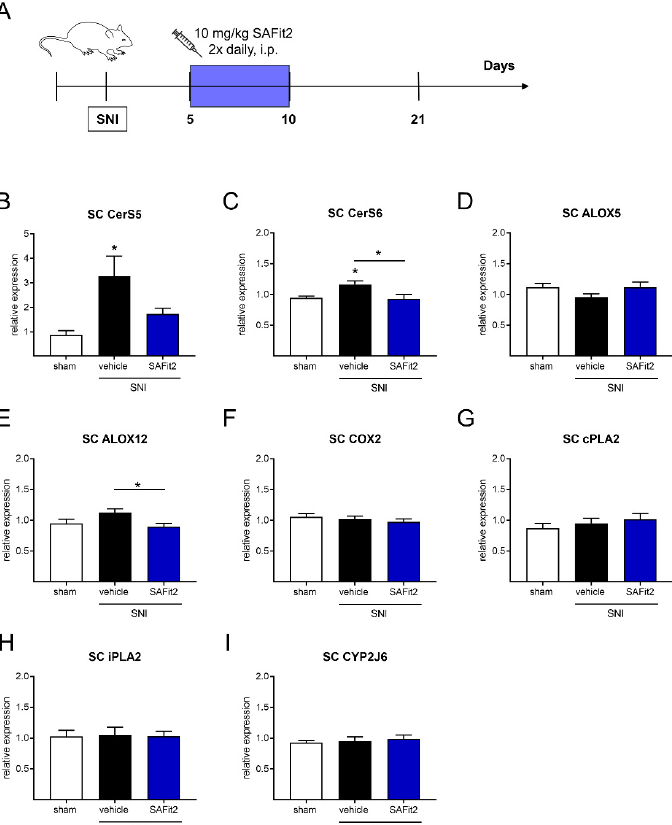
Figure 2. Gene expression of ceramide synthases, lipoxygenases, phospholipases, and epoxygenases in the spinal cord of nerve-injured mice after additional SAFit2 treatment. ( A ) Schematic illustration of the experimental procedure: SNI surgery was performed followed by treatment with either 10 mg/kg SAFit2 or the vehicle on six consecutive days (days five to ten) after SNI, as depicted in Figure 1. The gene expression of ceramide synthases ( B , C ), lipoxygenases ( D – F ), phospholipases ( G , H ), and epoxygenase ( I ) was measured 21 days after the surgery. The data are displayed as the mean ± SEM of technical replicates of three to four mice per treatment. * p < 0.05, as per one-way ANOVA with a Tukey’s post-hoc test. Abbreviations: SAFit2: selective antagonist of FKBP51 by induced fit 2; SNI: spared nerve